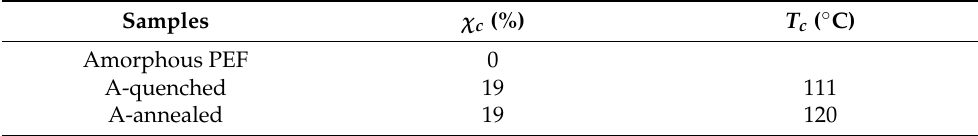
Table 2. χ c and T c of biaxially stretched